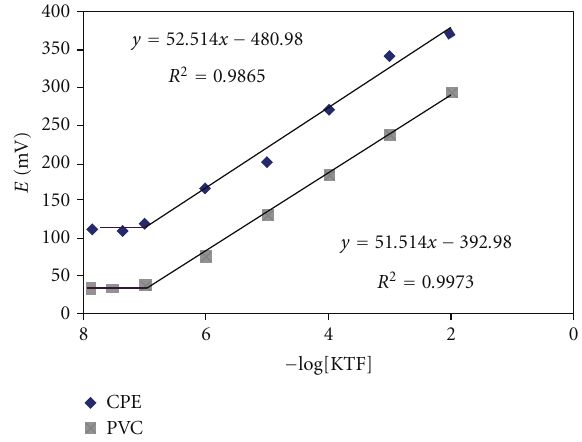
Figure 2: Calibration curve for KTF using CPE and PVC membrane